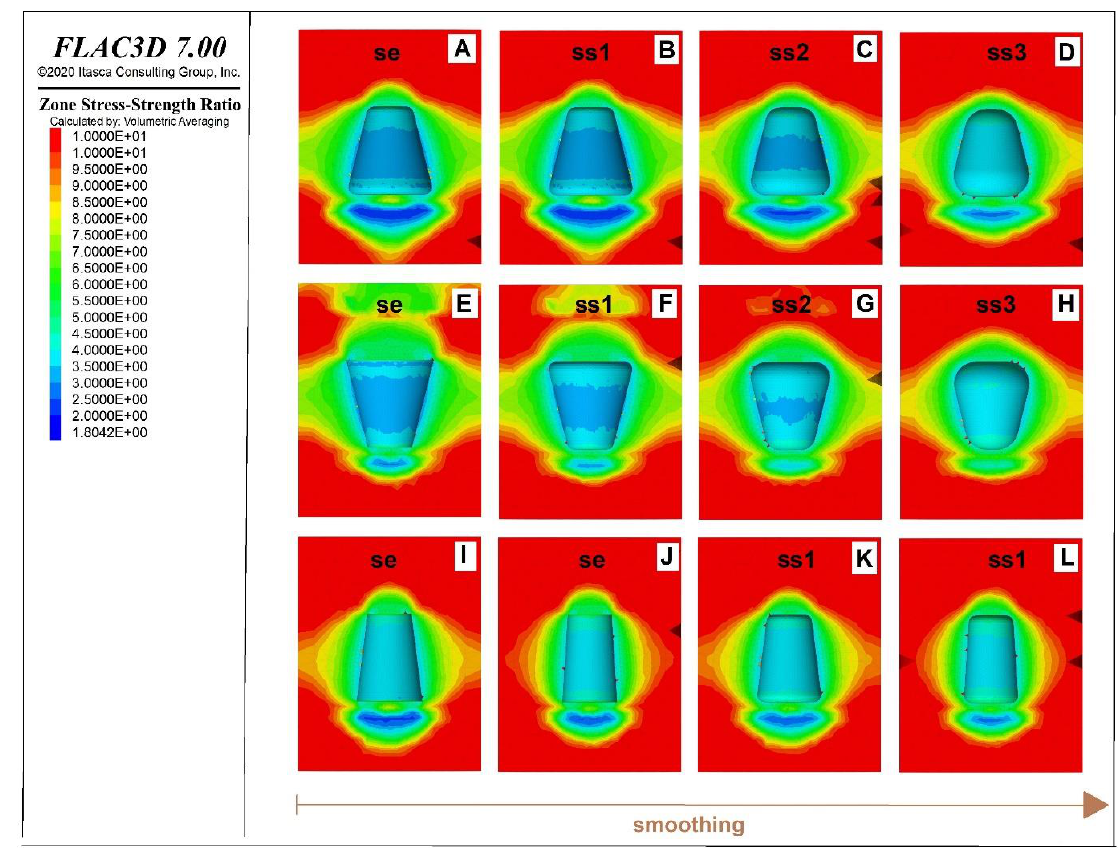
Figure 15. The SSR value and distribution in the enlarged caverns; the first withdrawal period: ( A – H ) maximum initial diameter of 120 m, ( I , J ) maximum initial diameter of 90 m, ( K , L ) maximum initial diameter of 75 m.